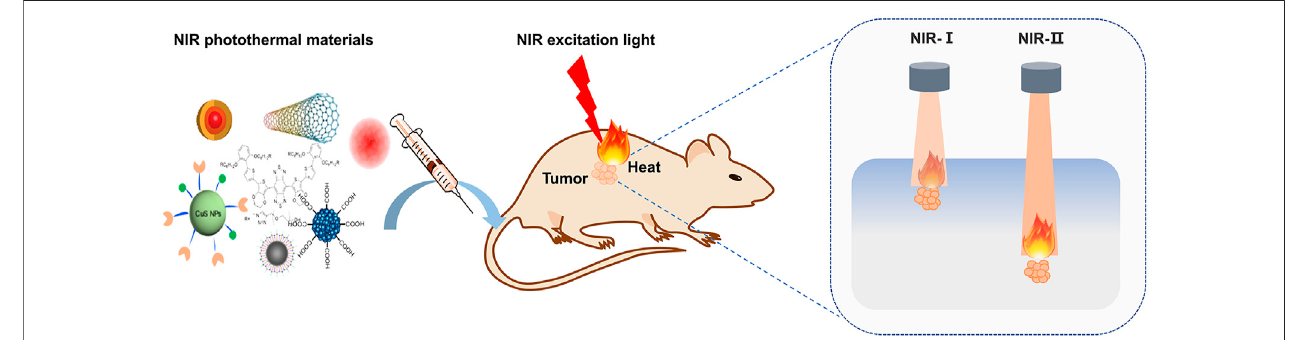
FIGURE 1 | Schematic of NIR photothermal therapy. The photothermal materials were administrated and enter the tumor cells, then excited by NIR light and transform the light energy into heat to ablate tumor cells. The lights in NIR-I and NIR-II regions have different penetration depths through tissues, and NIR-II excitation is superior to its counterpart and promised better prospect for the treatment of deep